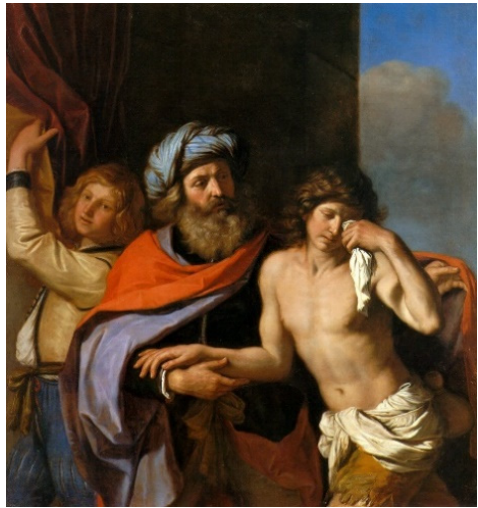
Figure 9. Guercino, Return of the Prodigal Son , 1654/5, Timken Museum, San Diego, CA, USA. Photo: Wikimedia Commons, Public Domain.